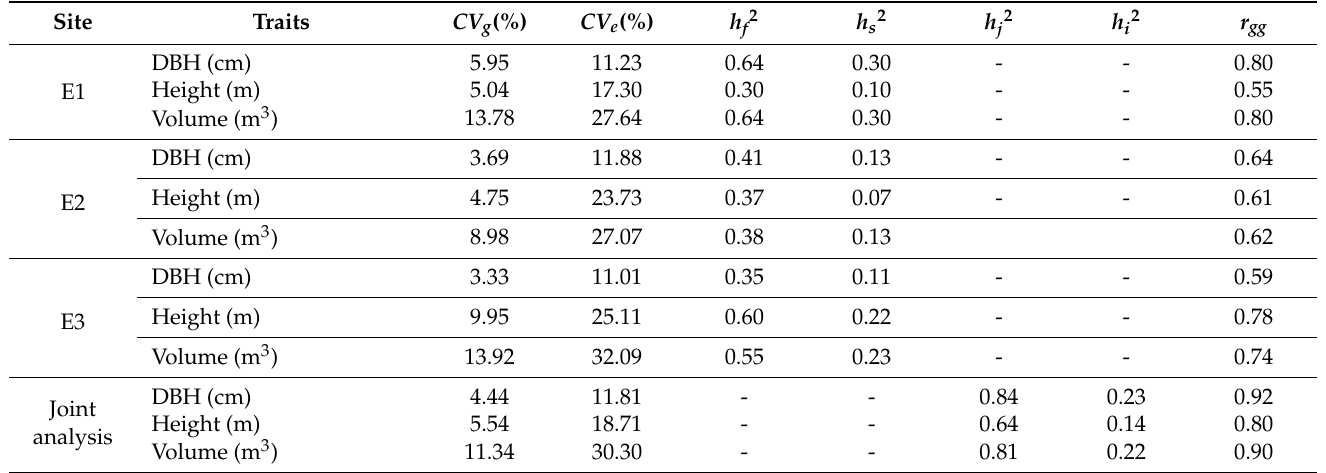
Table 5. Estimates of genetic parameters for DBH, H t , and the individual volume of the clones at the three sites.